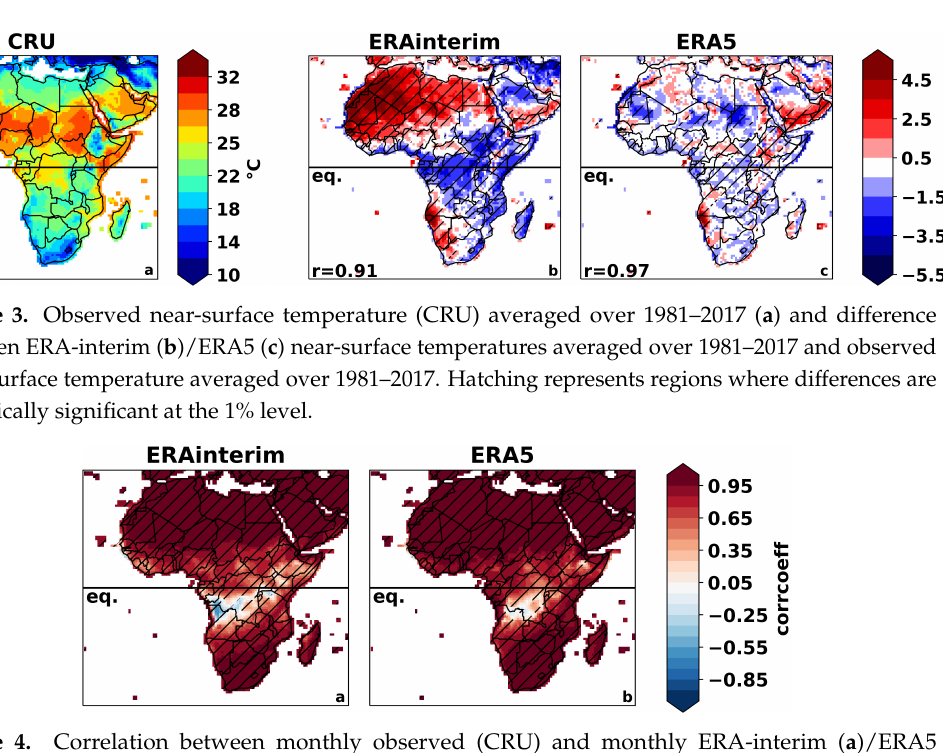
Figure 4. Correlation between monthly observed (CRU) and monthly ERA-interim ( a )/ERA5 ( b ) near-surface temperatures from 1981–2017. Hatching represents regions where correlation values are statistically significant at the 1% level.